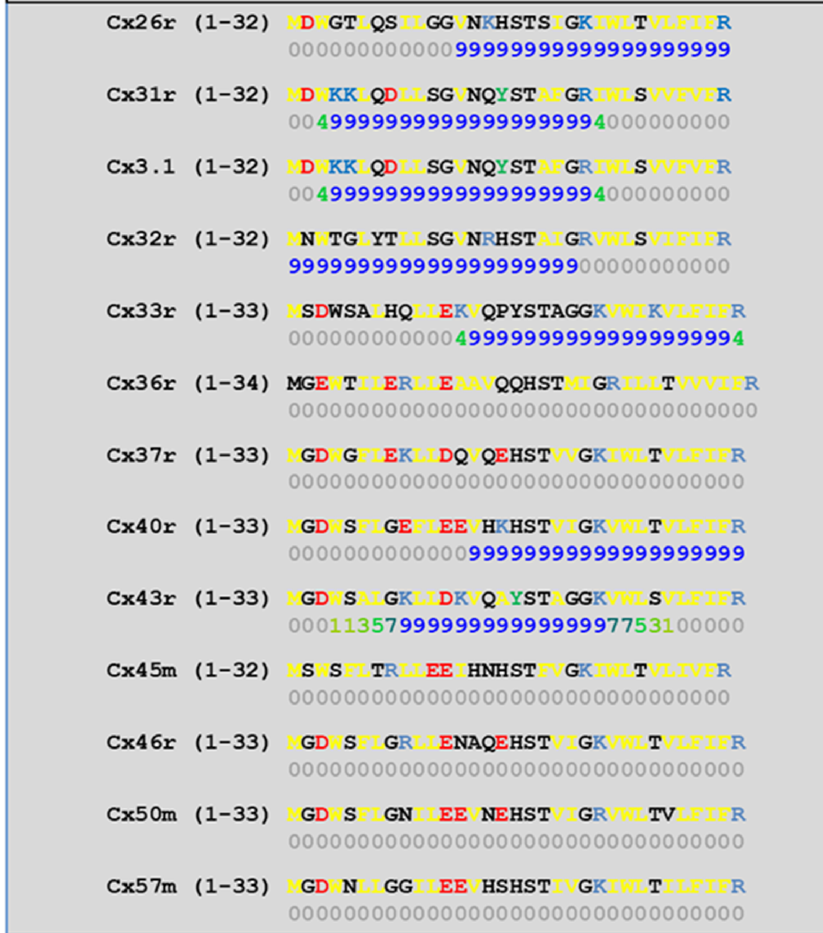
Figure 5. Predicted CaM-binding Site at NT domain.